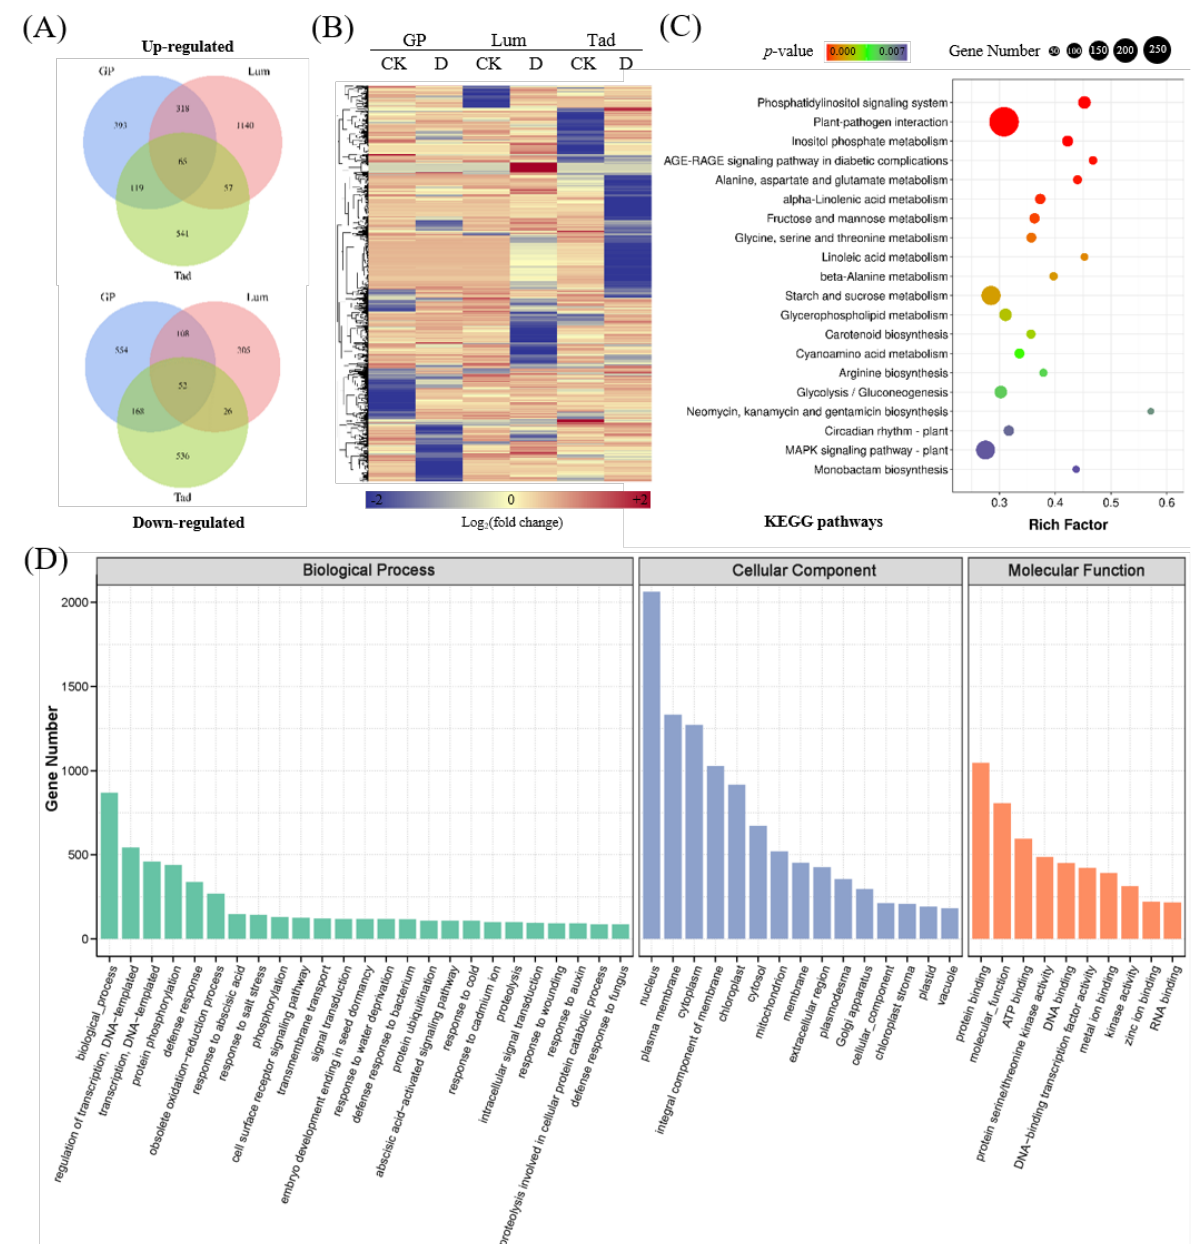
Figure 6. Identification and characterization of drought-responsive, differentially expressed genes (DEGs) in GP, Lum, and Tad. ( A ) Venn diagram of up- and downregulated DEGs in three barley genotypes. ( B ) Hierarchical clustering analysis of drought-responsive DEGs. The samples and treatments are shown under each column. ( C ) Enrichment analysis of drought-responsive DEGs by the Kyoto Encyclopedia of Genes and Genomes (KEGG). The color of the dot represents p -value, and the size of the dot represents the number of DEGs mapped to the reference pathway. ( D ) Gene ontology (GO) analysis of drought-responsive DEGs. GO terms are divided into cellular component, molecular function, and biological process,